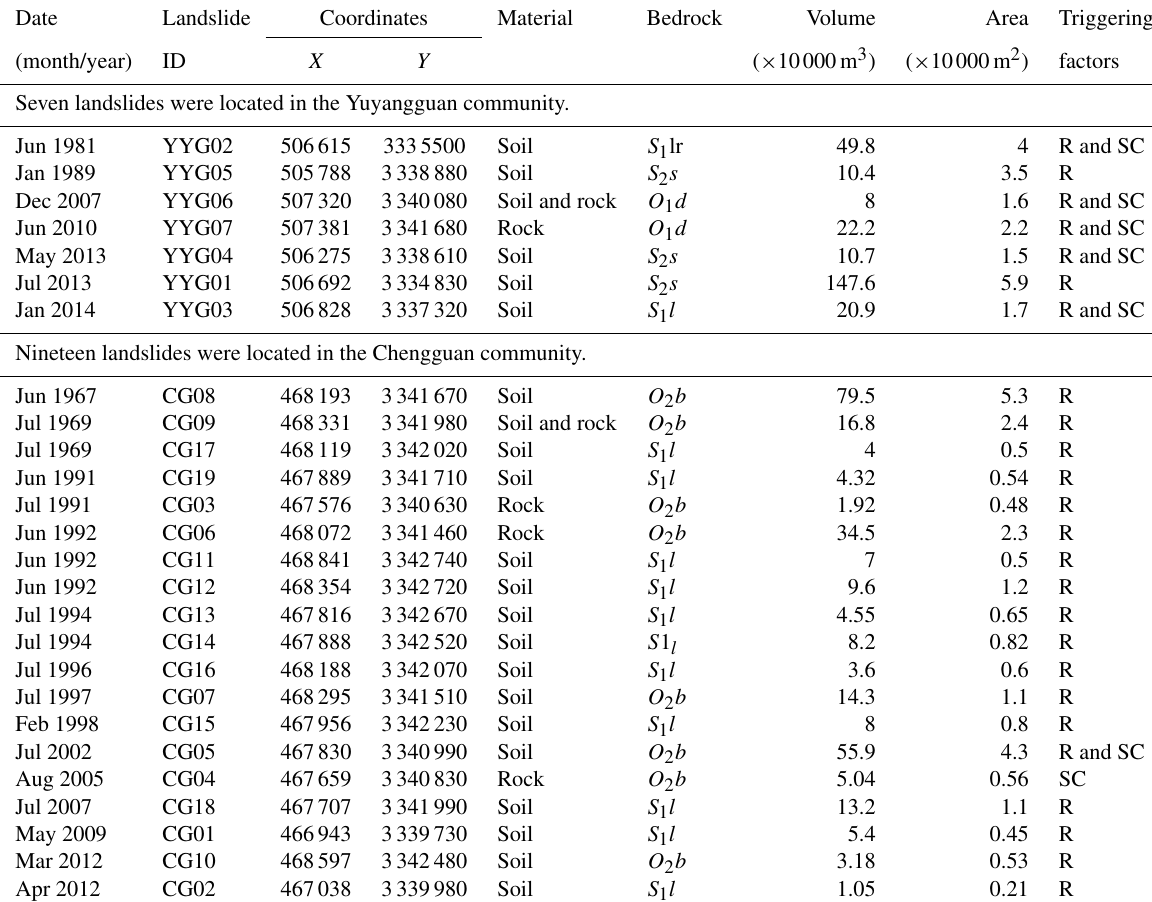
Table 2. Historical landslides investigated in the field by the authors.